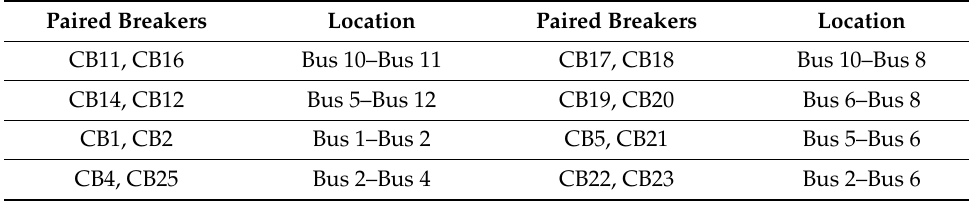
Table 5. Paired circuit breakers and their